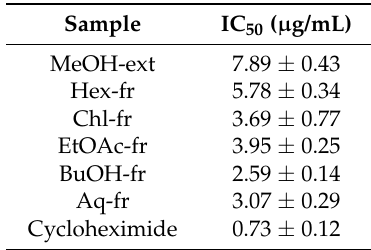
Table 2. In vitro cytotoxicity assay of Trillium govanianum rhizome methanol extract and its fractions on NIH 3T3 mouse embryo